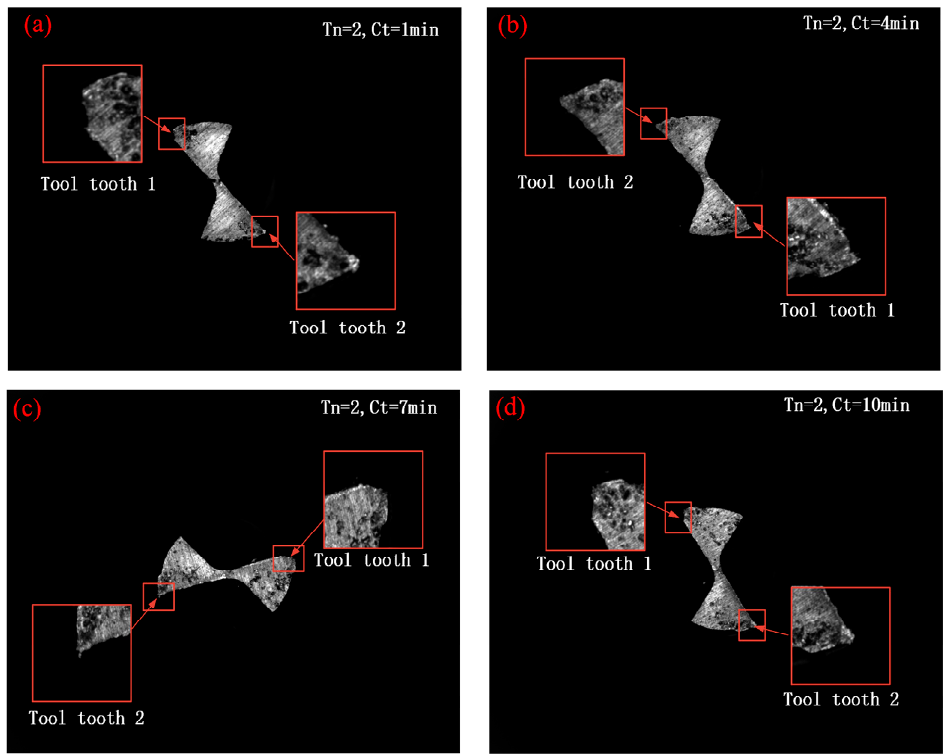
Figure 18. In situ captured wear images at different cutting times of tool No. 2: ( a ) cutting time 1 min; ( b ) cutting time 4 min; ( c ) cutting time 7 min; ( d ) cutting time 10 min.